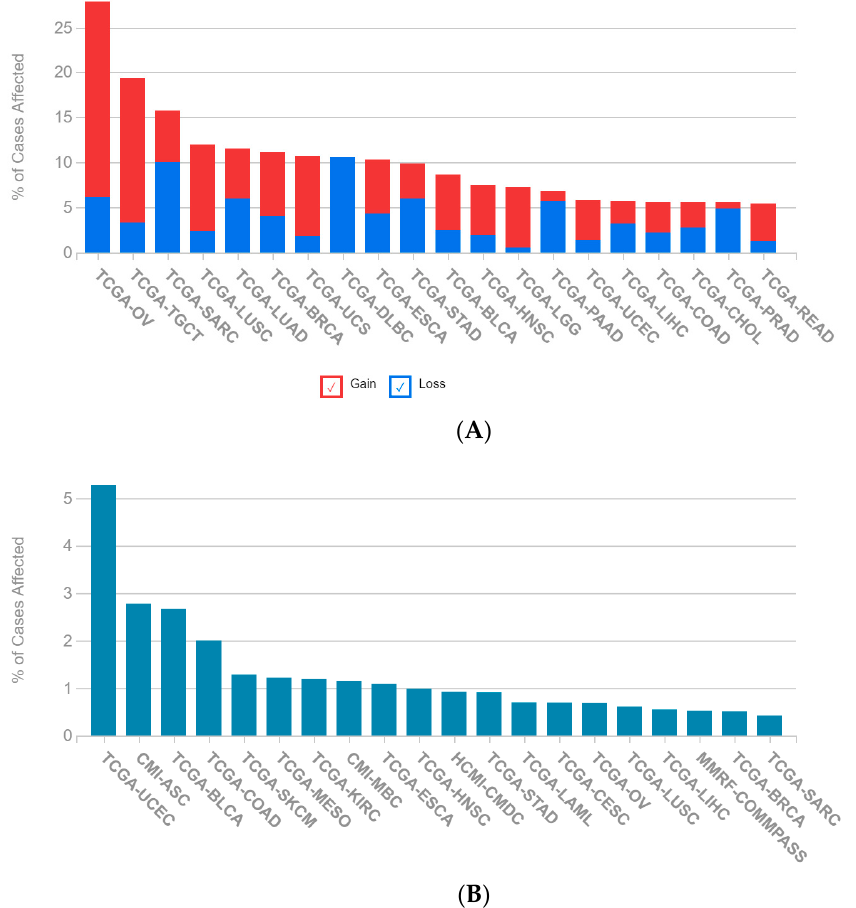
Figure A3. CNV and mutation distribution of CD27 in different cancer types. ( A ) CNV distribution. ( B ) Mutation distribution.